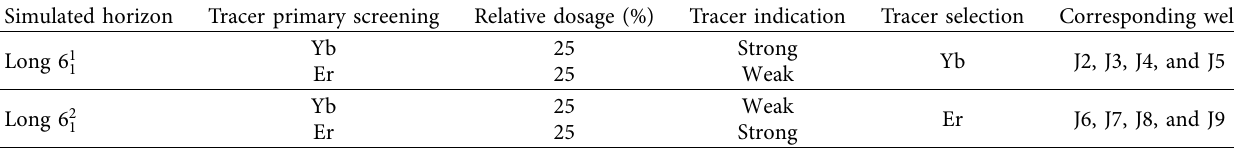
Table 1: Nanometre tracer type selection of well cluster J1.